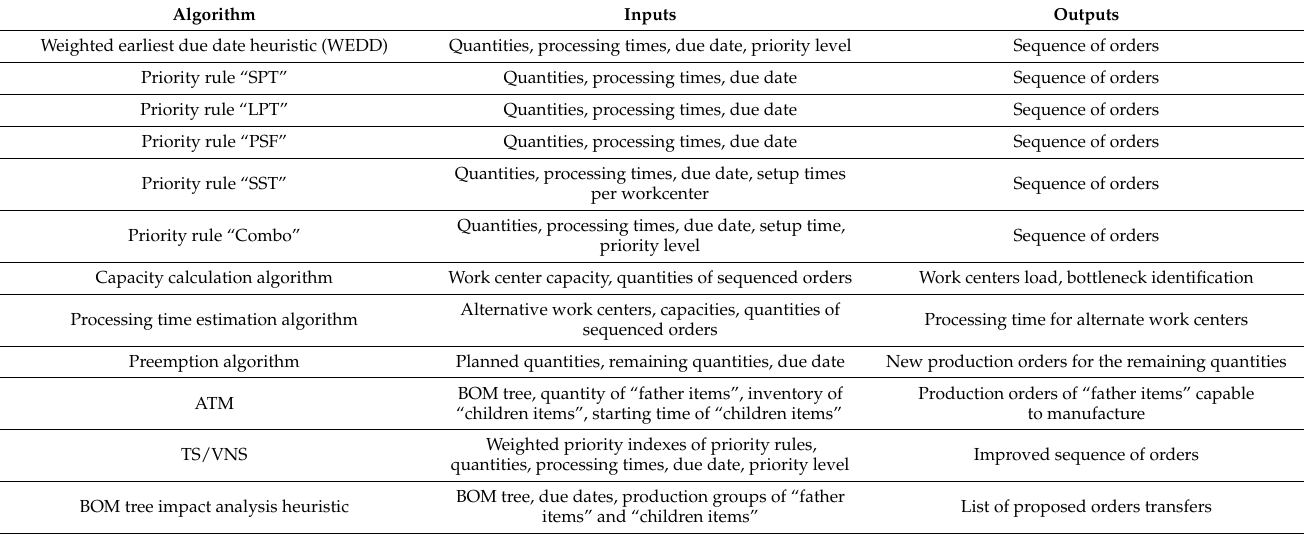
Table 6. Synopsis of core functionality